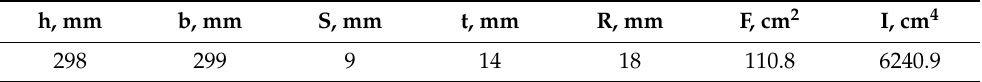
Figure 8. Dimensions of the 30K1 I-beam profile ( left ) and thermocouples arrangement ( right ). Table 1. Characteristics of the 30K1 I-beam profile.